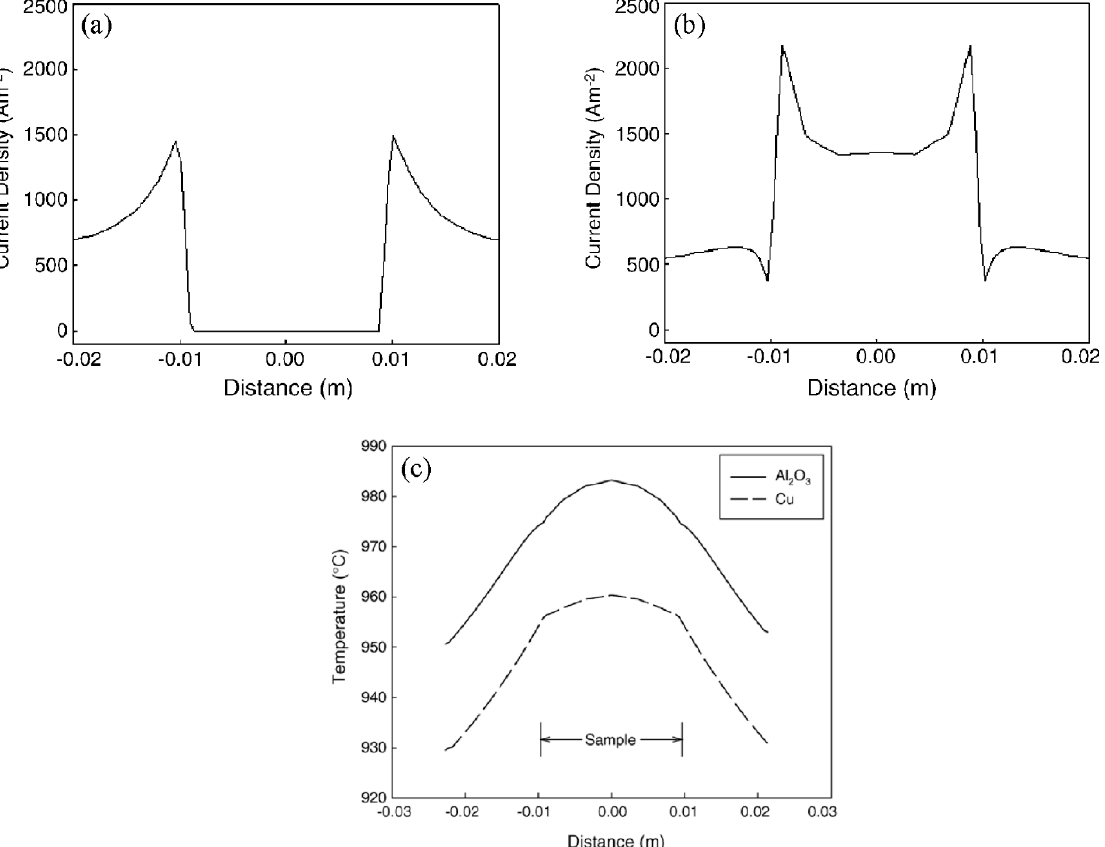
Figure 11. Radial current density distribution for non-conducting and conducting materials (applied voltage: 5V): Al 2 O 3 ( a ) and Cu ( b ). Temperature distribution for Al 2 O 3 and Cu (constant current applied: 1000 A) ( c ). In all cases, the profile is passing through the center of the samples and though the graphite molds surrounding them [80]. Reproduced with permission from Materials Science and Engineering: A , published by Elsevier, 2005.